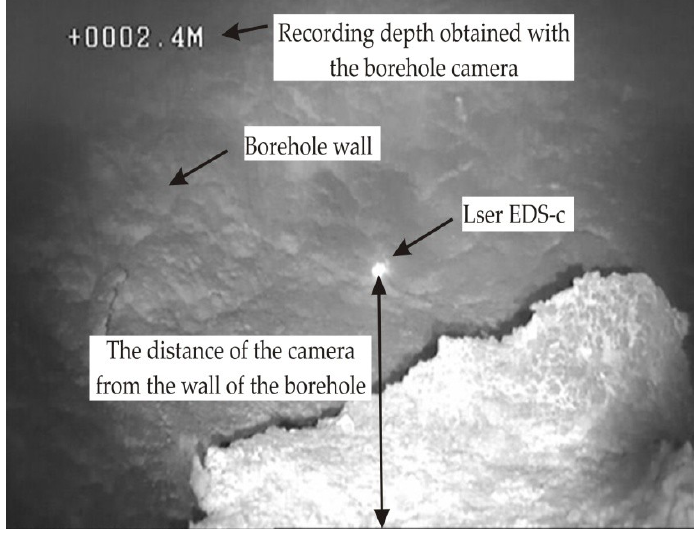
Figure 9. Depth camera snapshot of the spherical expansion.